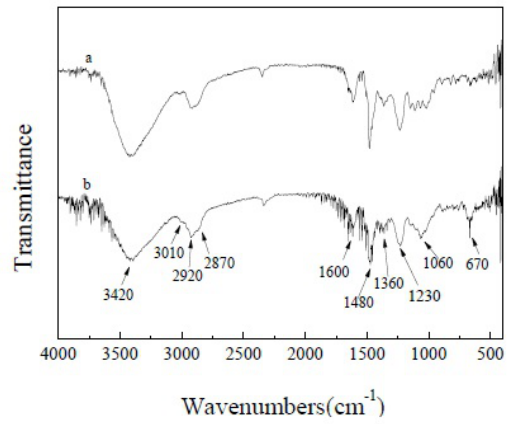
Figure 2: The FT-IR spectra of PRs(a) and HPRs